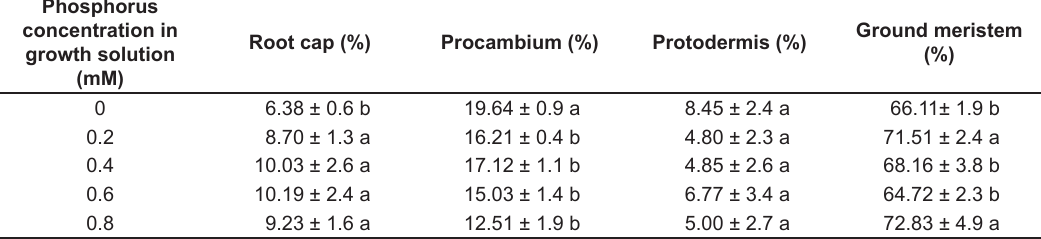
Table 2 Anatomical traits of root meristems of T. domingensis grown under different phosphorus concentrations. Data is shown as mean ± standard deviation. Means followed by the same letter in rows do not differ by the Scott- Knott test to